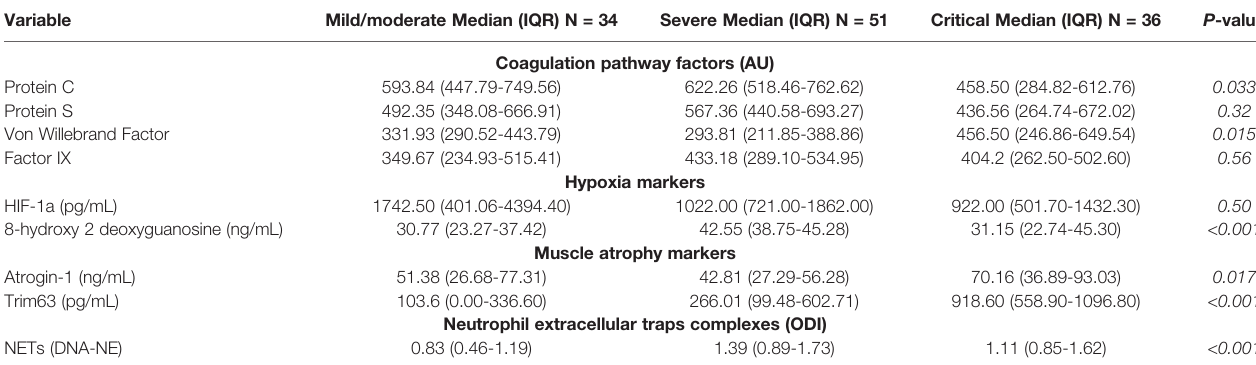
TABLE 4 | Other biological markers in patients with COVID-19 according to disease severity. Variable